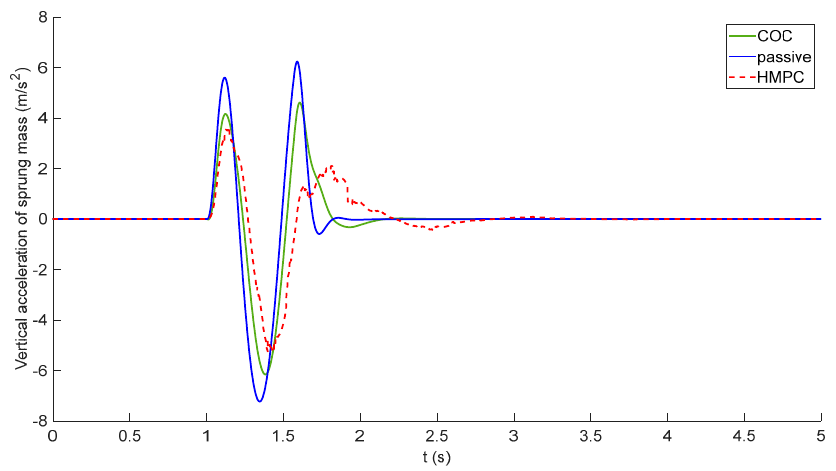
Figure 21. Vertical acceleration of sprung mass.